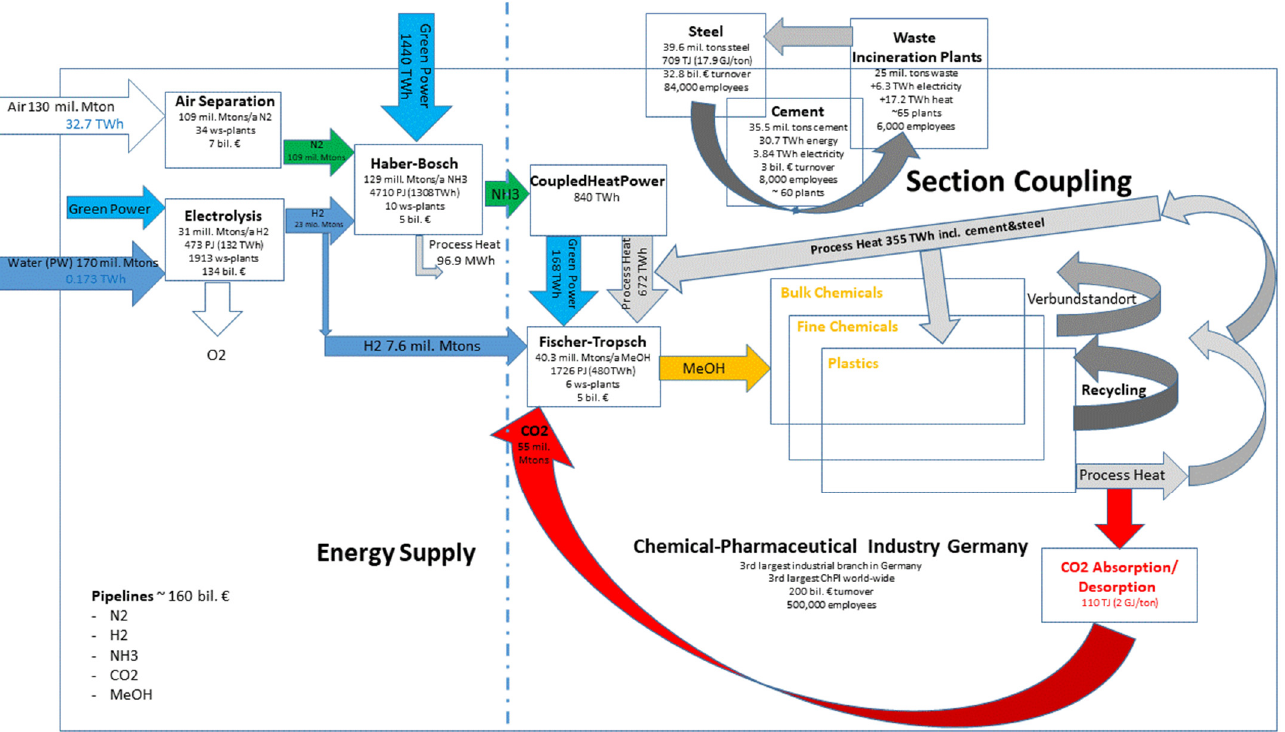
Figure 6. In- and outlet mass and energy estimations of German Chemical–Pharmaceutical Industry in 2050. Table 3. Inlet mass and energy streams of German Chemical–Pharmaceutical Industry in 2050.